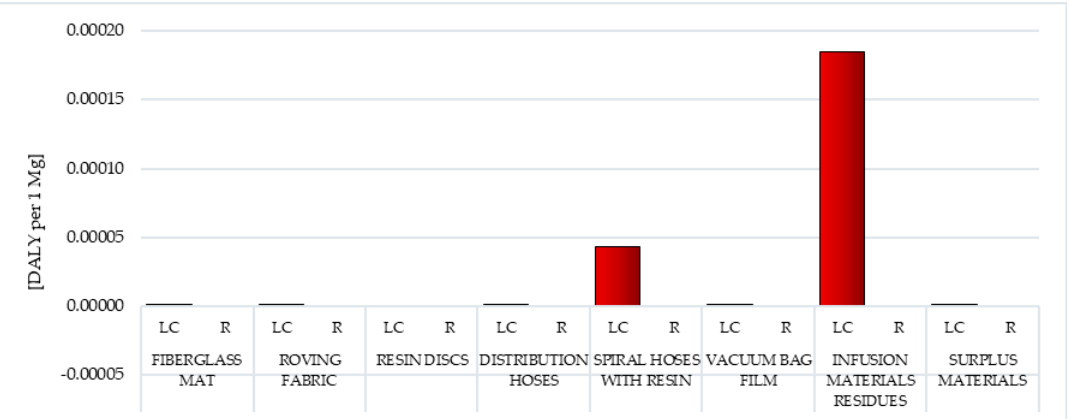
Figure 9. Characterization results of environmental consequences for compounds causing an increase in the ozone hole present in selected postproduction waste of wind power plant blades: LC—life cycle, R—recycling [unit: DALY per 1